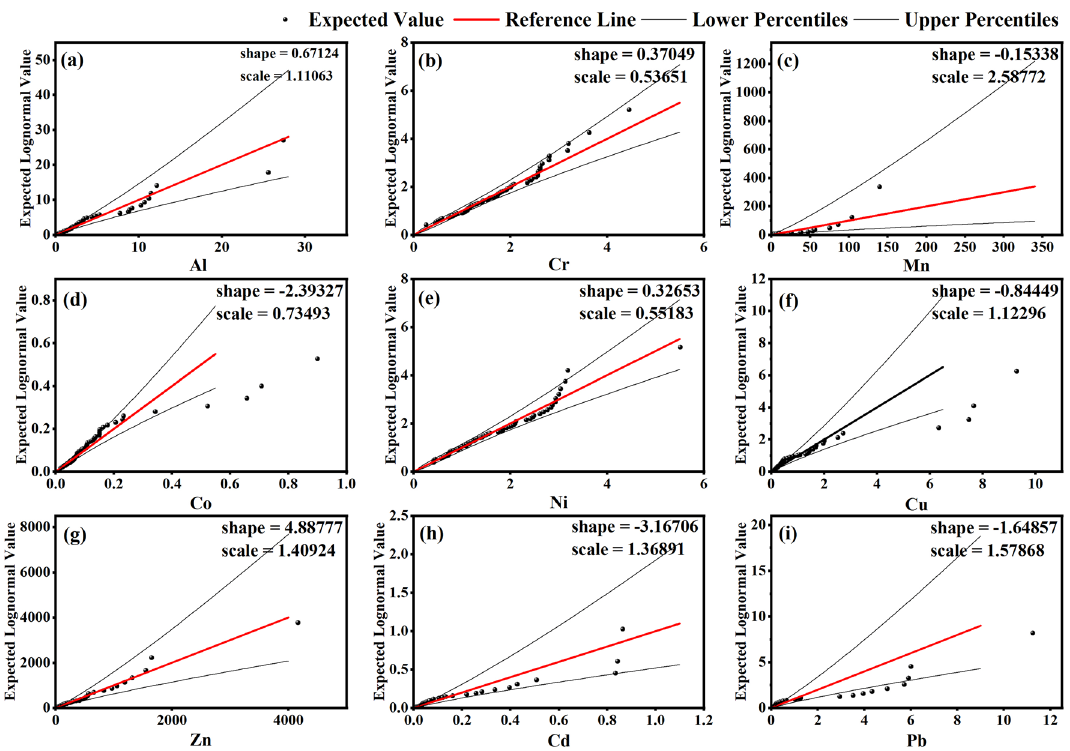
Figure 2. Quantile—Quantile plots of different HMs in the study